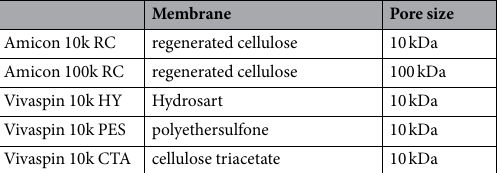
(Table 1). For each column, 2 mL sample was concentrated 20-fold (100 µ L) by centrifugation at 3,000 g and 4 °C. Three end-point samples per column were analyzed: the concentrate, the filtrate and the membrane lysate